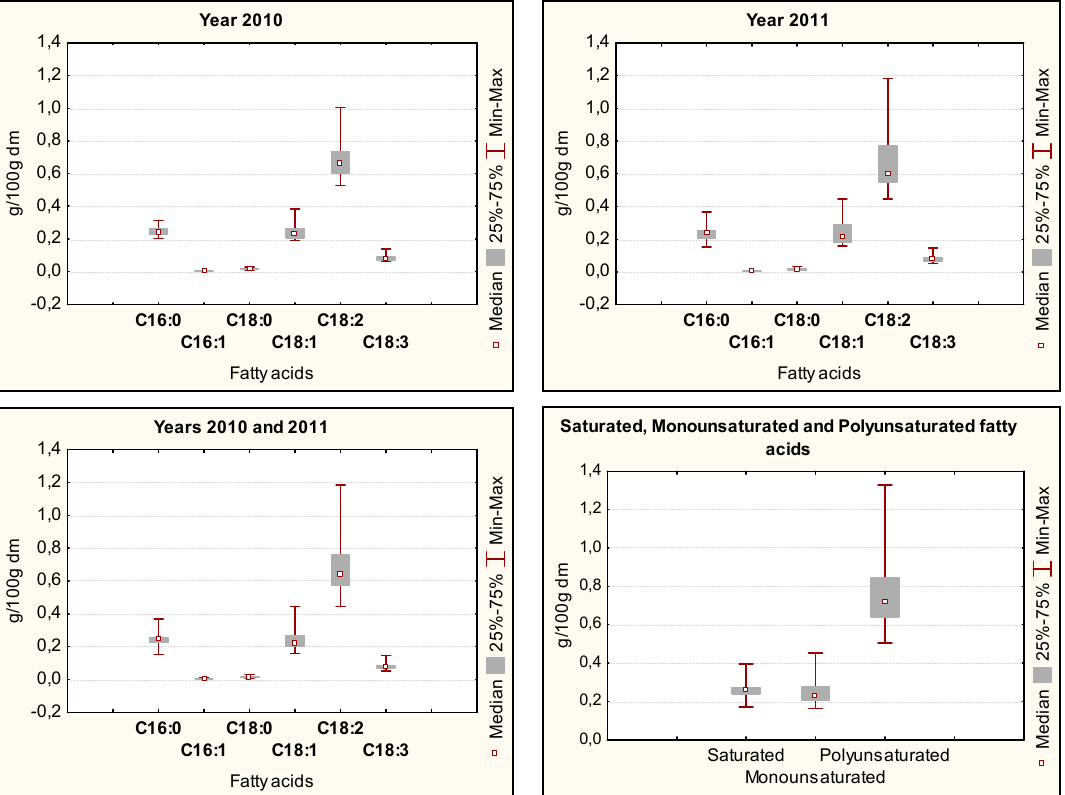
Figure 1. Box plot (percentiles) of fatty acids in samples of Italian durum wheat (10 cultivars, grown in the same location for two consecutive years).